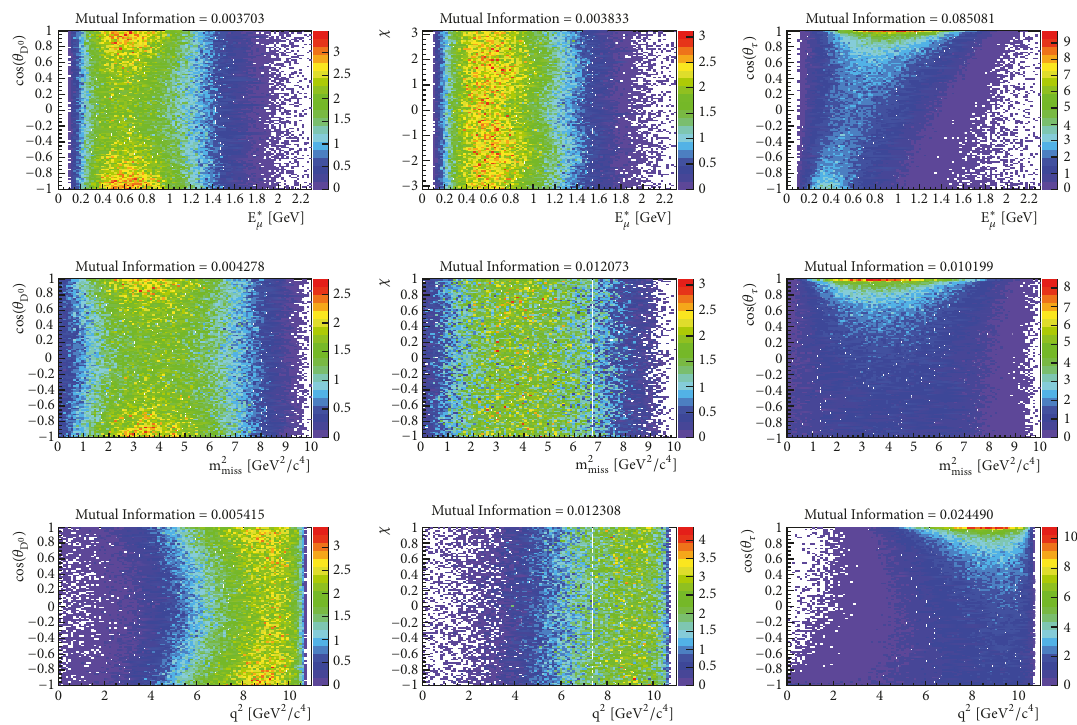
0 0.2 0.4 0.6 0.8 1 1.2 1.4 1.6 1.8 2